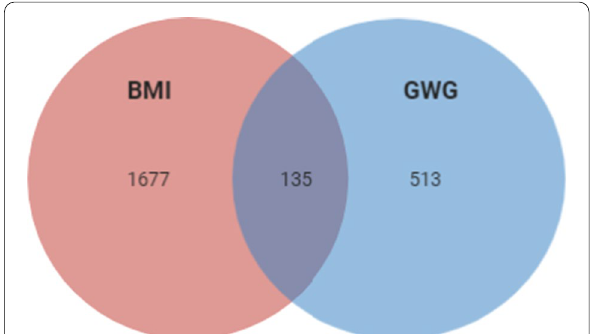
Fig. 3 Overlap of the correlation of imputed expression of genes which influence BMI in ARIC and T2D‑GENES cohorts, GWG in T1DM cohort and both